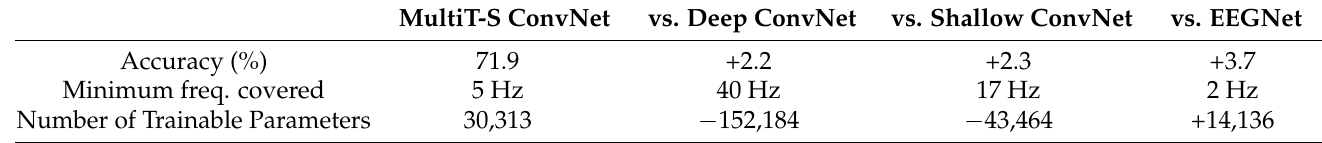
Table 3. The comparison of model performance between the proposed MultiT-S ConvNet and existing ConvNets. The accuracy (%) is the average from all experiments in this study. It calculates differences in the accuracy between MultiT-S ConvNet and other models, and the positive mark denotes a higher accuracy of the MultiT-S ConvNet. The minimum frequency (Hz) covered by each model is displayed. The bottom row computes the number of trainable parameters in dependence on the sampling rate of the SEED dataset. The negative and positive marks denote a decrease and increase of trainable parameters required by the MultiT-S ConvNet, compared with indicated